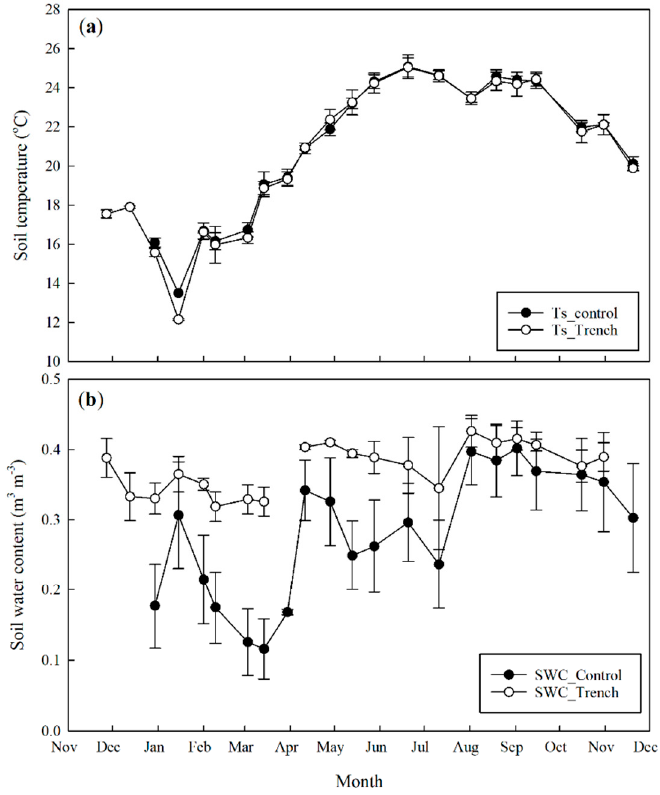
Figure 2. Temporal dynamics of soil temperature ( a ) and soil water content ( b ). Both soil temperature and soil water content were measured at a depth of 5 cm. Error bars represent standard